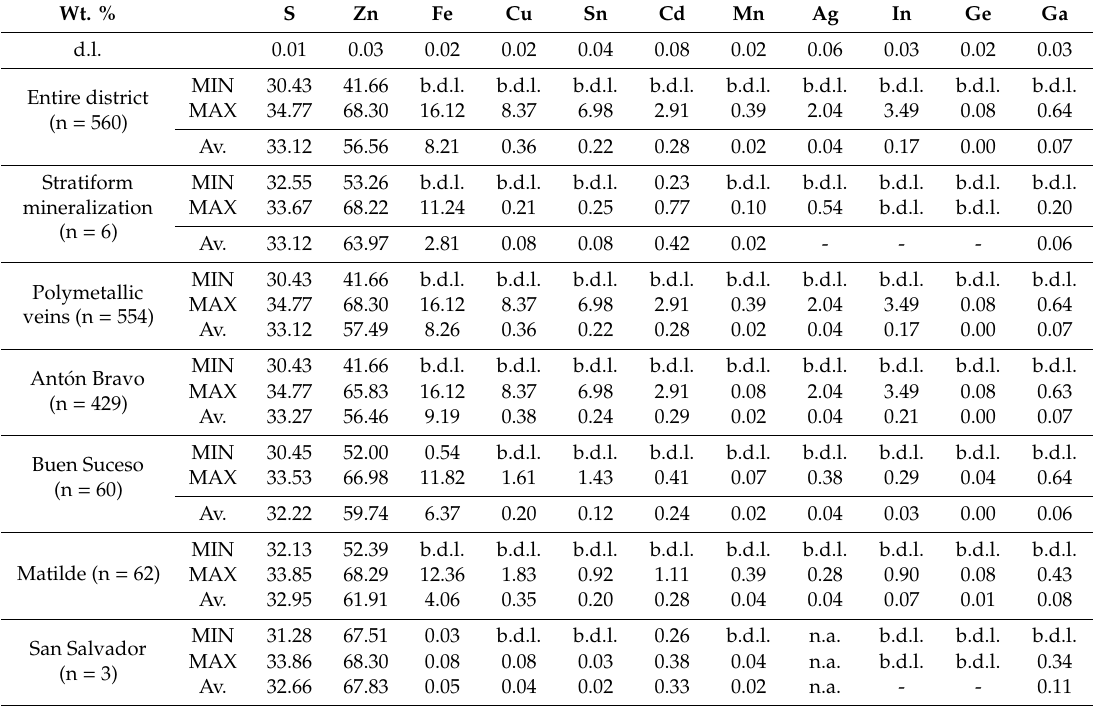
Table 2. Summary of element concentrations in sphalerite from the Huari Huari district (electron probe microanalysis